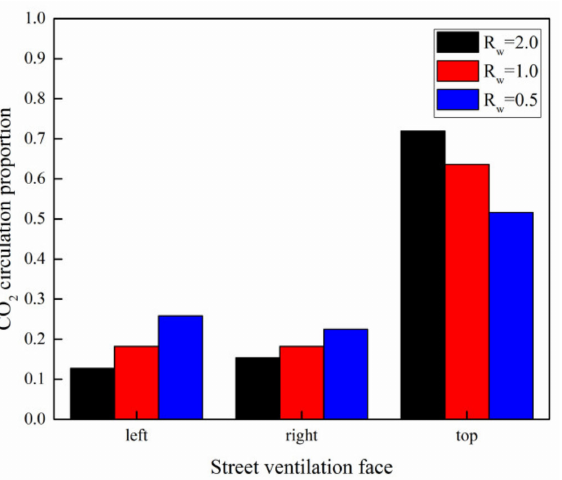
Figure 11. Flux proportion of pollutant per unit area of street ventilation surfaces with different aspect ratios.